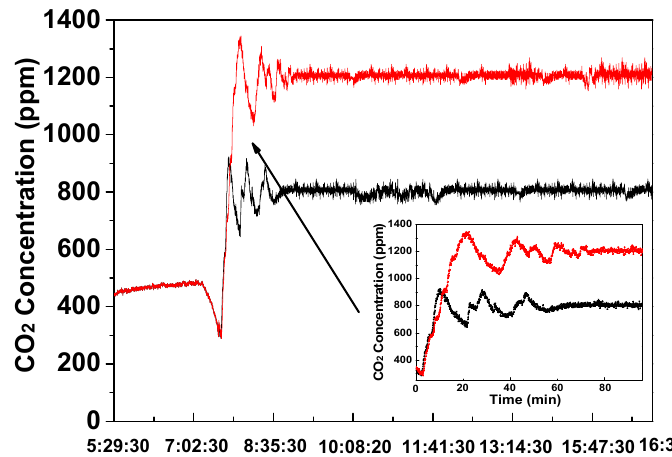
Figure 13. The measured CO 2 concentration under dynamic Fuzzy-PID control.